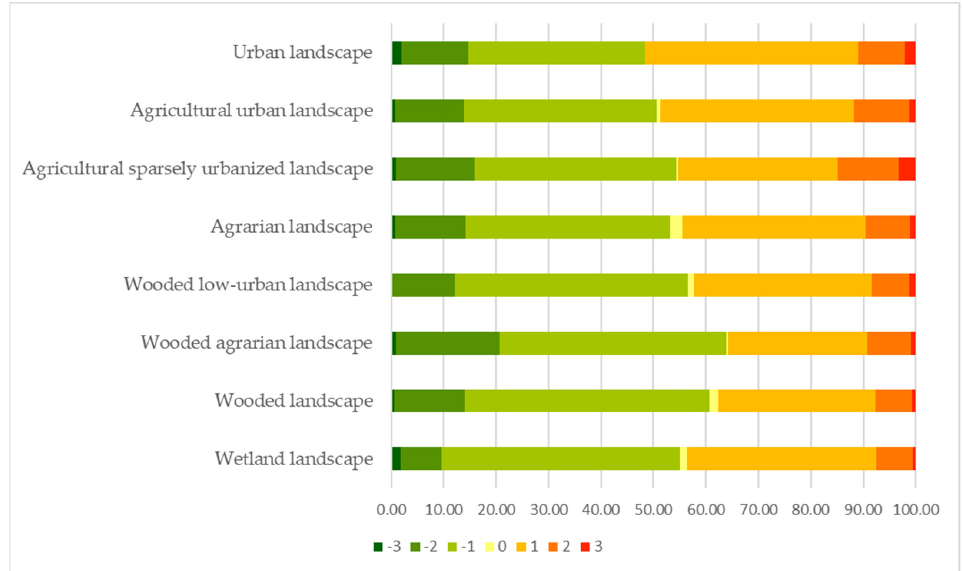
Figure 7. Distribution of landscape instability classes in areas of different landscape types (according to the National Landscape Management Plan).